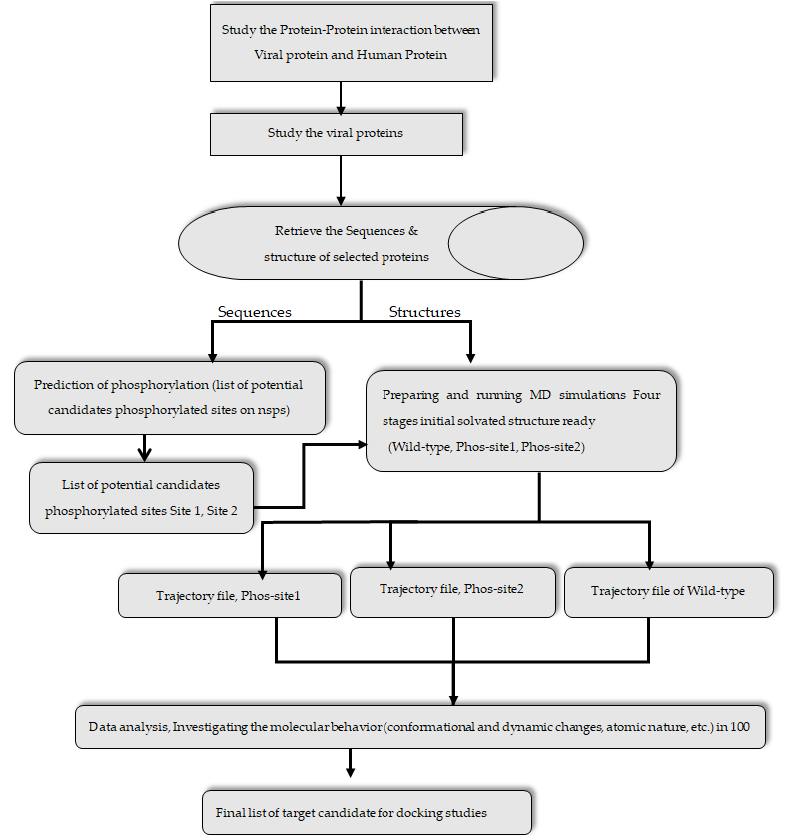
Figure 2. Pictorial representation of various methodologies followed in this